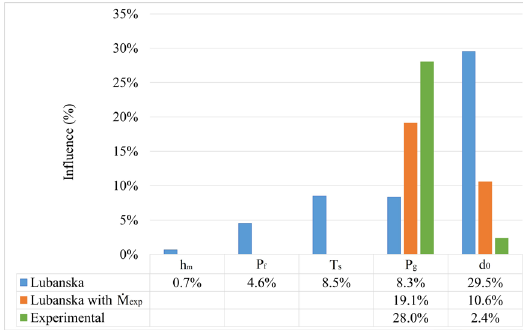
Figure 5. Parameters influence in the median particle size